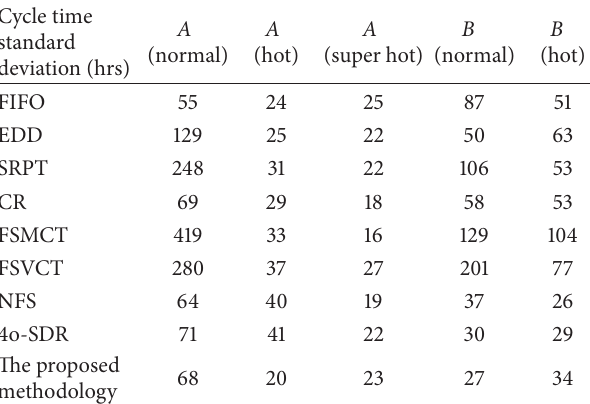
Table6:Theperformancelevelsofvariousapproachesforcycletime standard deviation.